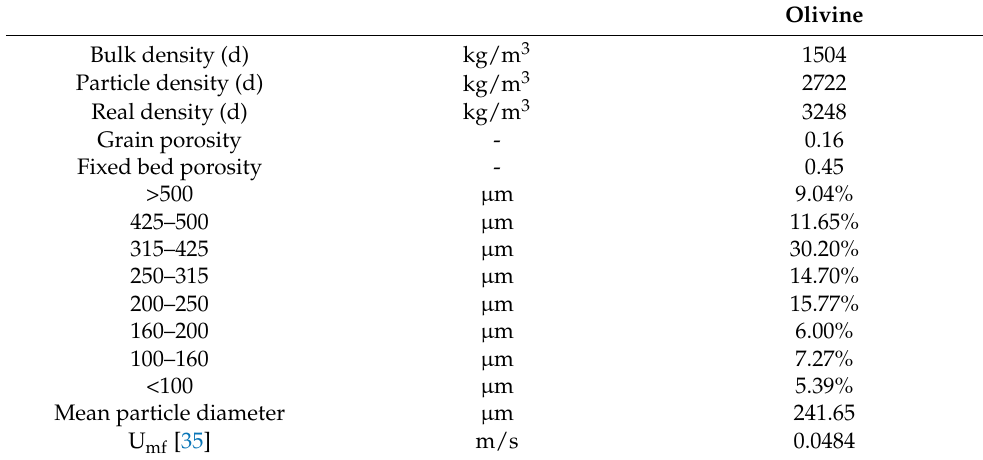
Table 2. Physiochemical characteristics of olivine used as bed